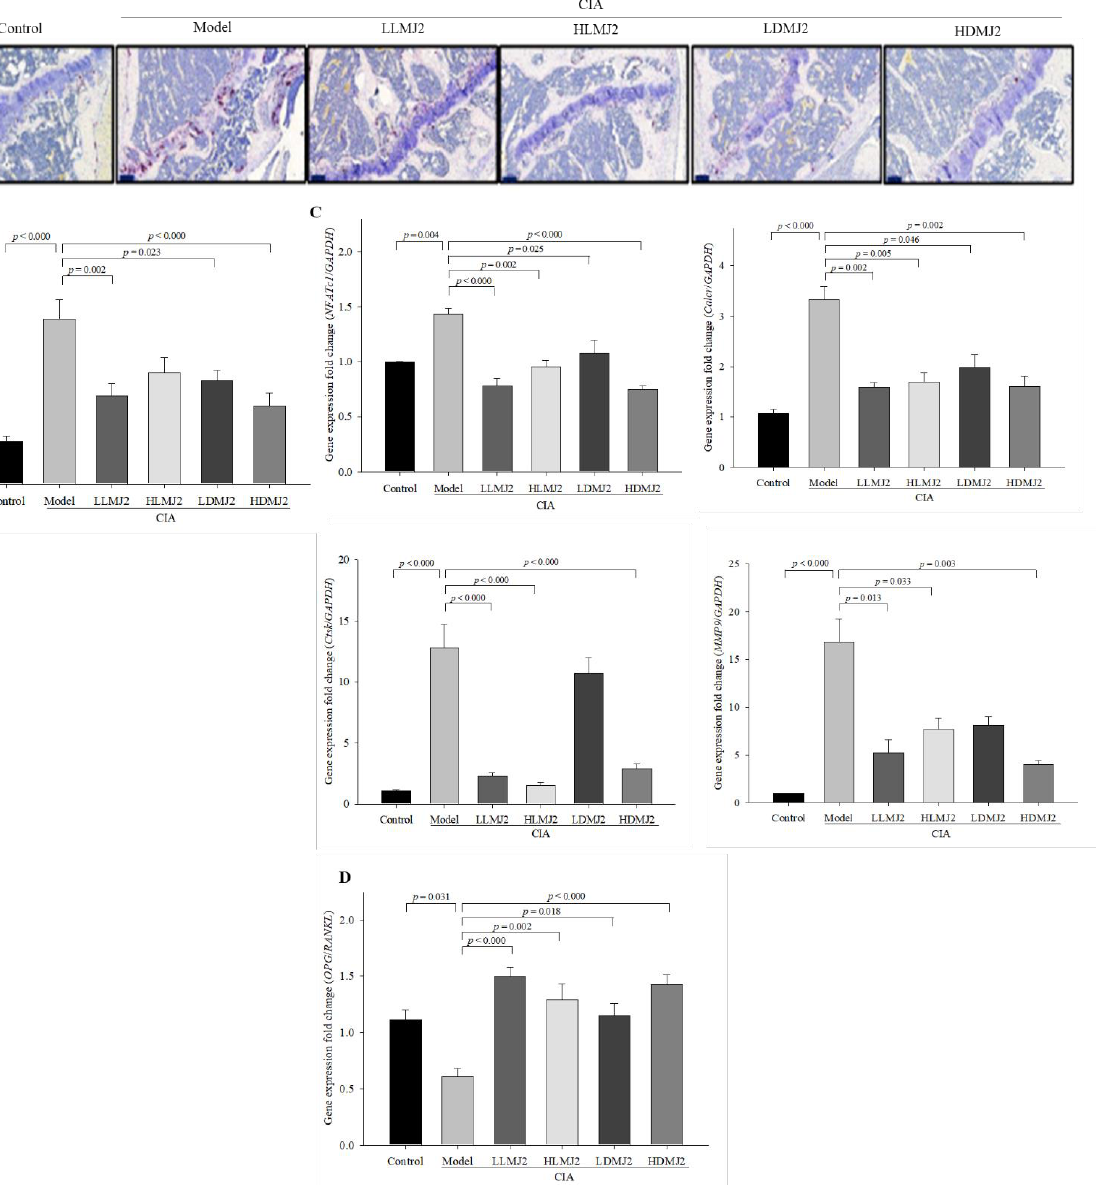
Figure 7. Inhibitory effect of MJ2 on osteoclast differentiation in CIA mice ( n = 8 per group). Osteoclasts were stained with TRAP staining in mice knee joints (100×, scale bar = 100 μm) ( A ), and TRAP(+) cells were counted ( B ). Expression levels of osteoclast differentiation-related genes ( C ) and OPG/RANKL ratio ( D ) were measured by qPCR. Data values indicate the mean ± standard error of the mean (SEM). One-way ANOVA followed by Tukey’s HSD was used to determine significance . CIA, collagen-induced arthritis; TRAP, tartrate-resistant acid phosphatase; NFATc1, nuclear factor of activated T-cells cytoplasmic 1; Calcr, calcitonin receptor; Ctsk, cathepsin K; MMP-9, matrix metalloproteinase-9; RANKL, receptor activator of the nuclear factor- κB ligand; OPG, osteoprotegerin. Among the osteoclast differentiation-related genes, expression levels of NFATc1 and Calcr were significantly reduced in the MJ2-administered groups and expression levels of Ctsk and MMP9 were significantly reduced in the MJ2-administered groups except for the LDMJ2 group when compared with the model group (Figure 7C). Meanwhile, the